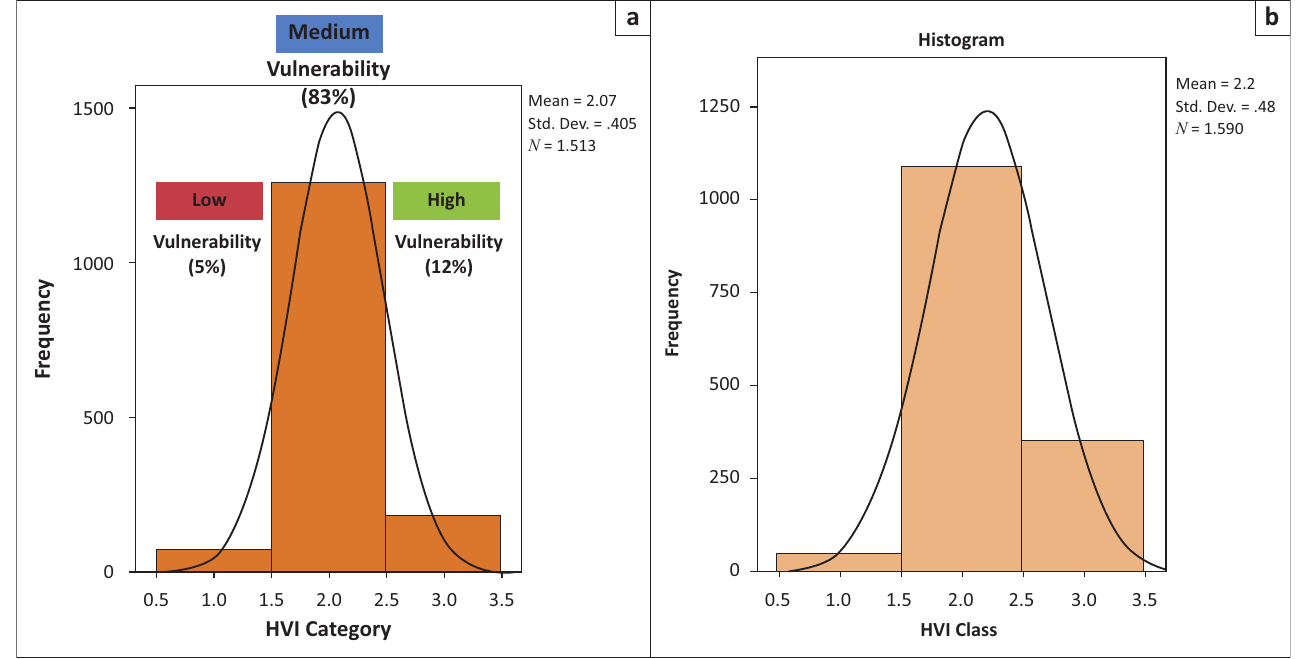
FIGURE 7: Different vulnerability levels of households from (a) Lambani and (b) Alice.